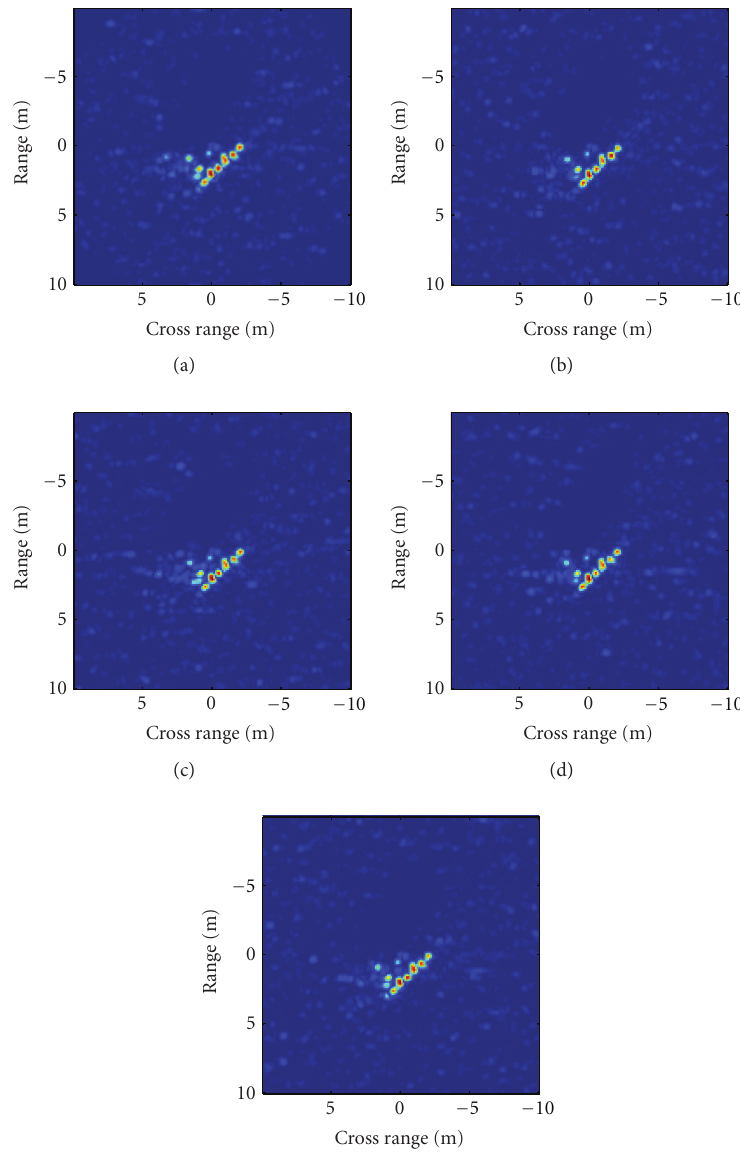
F 7: e 2D HH-polarization SAR images of the tank target above Gaussian rough surfaces with different sizes, in which the incident , ), other parameters are the same as in Figure 5. (a) e SAR image of the tank above rough surface of angle is ( ∘ ∘ 𝜙𝜙 𝜃 𝜙𝜃 𝜃𝜃 𝜃 𝜃𝜃